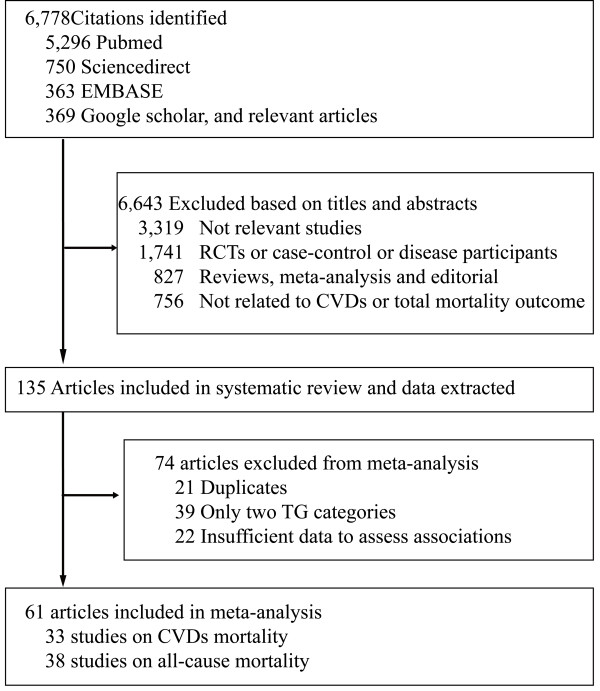
Flow diagram of study selection. TG: Triglycerides; CVDs: Cardiovascular diseases